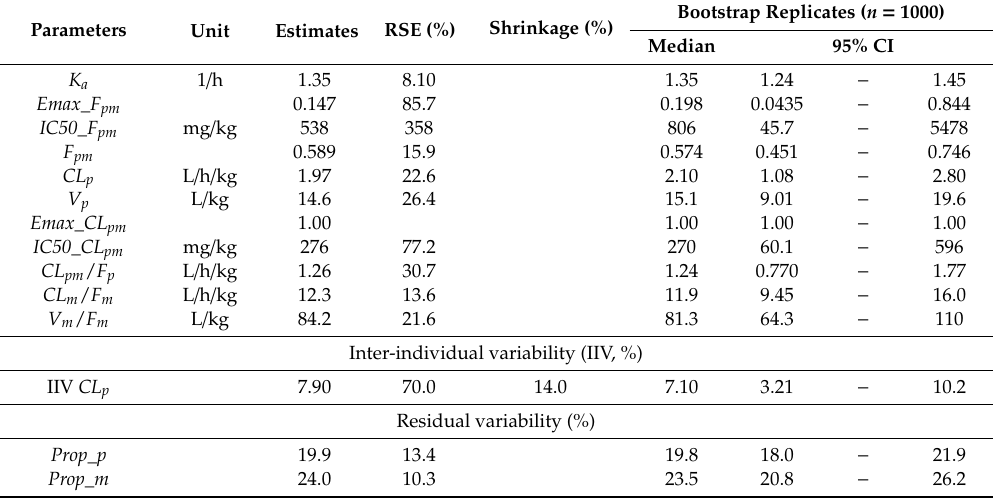
Table 2. Parameter estimates from the final model and results of bootstrap validation for DLX and 4-HD after a single oral administration of DLX at dose of 40 mg without or with co-administration with PPL 500 or 1500 mg / kg in